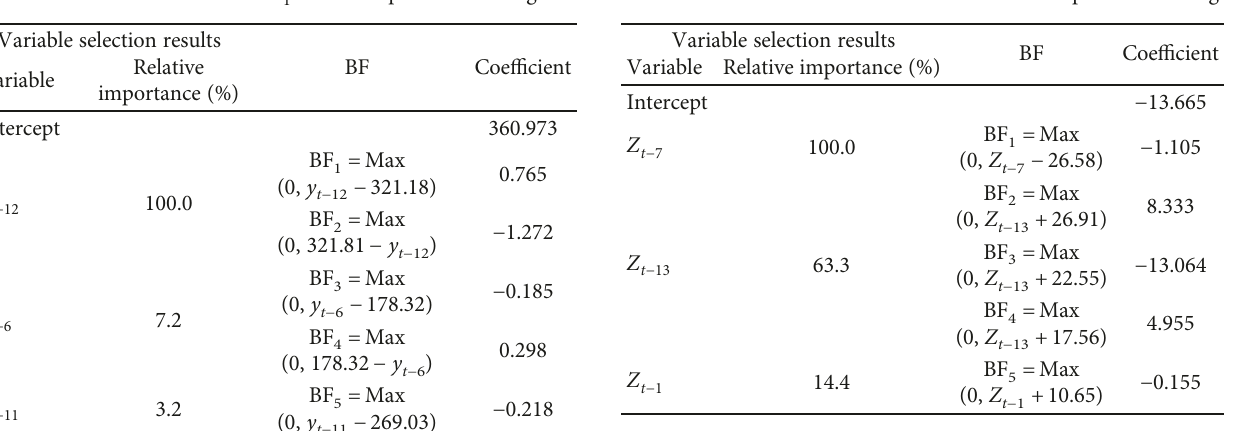
Table 9: The results of MARS for wheat price forecasting. Table 10: The results of ARIMA-MARS for wheat price 1